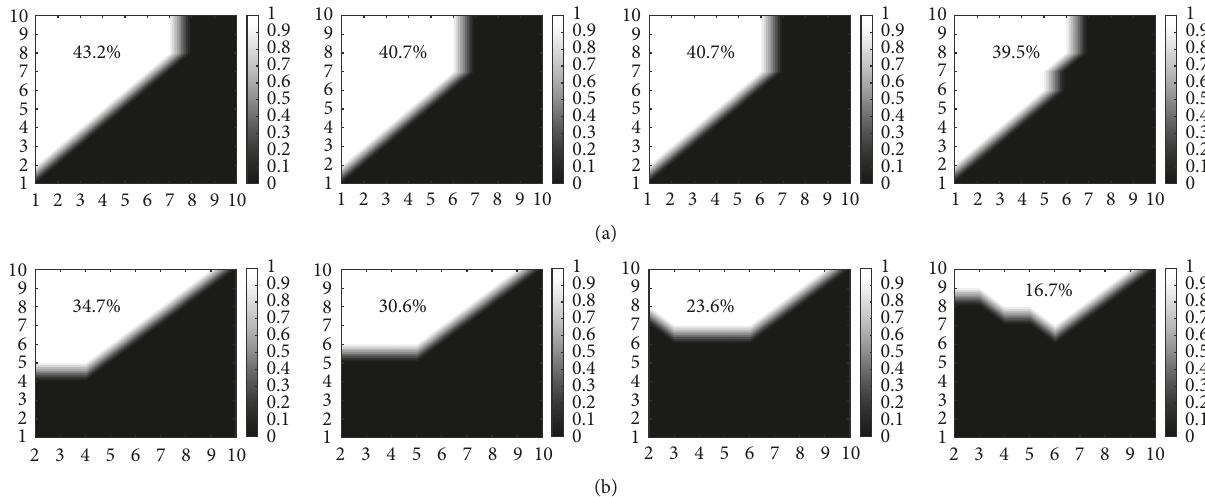
Figure 2: Illustration of phase transition: (a) determinant-type measure, 𝑁 = 50, 100, 150, 200 ; (b) ℓ 1 -norm, 𝑁 = 50, 100, 150, 200 (from left to right).